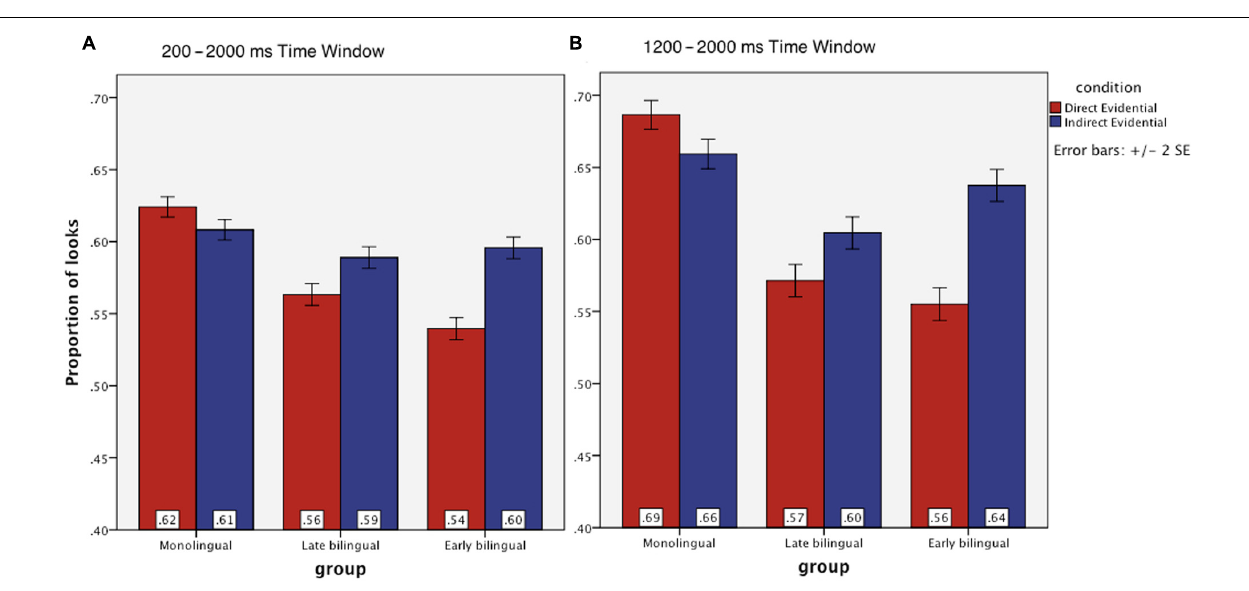
FIGURE 3 | Mean proportions of target fixations in three groups of participants during their processing of direct and indirect evidentials in two different time windows: (A) 200–2000 ms and (B) 1200–2000 ms after verb